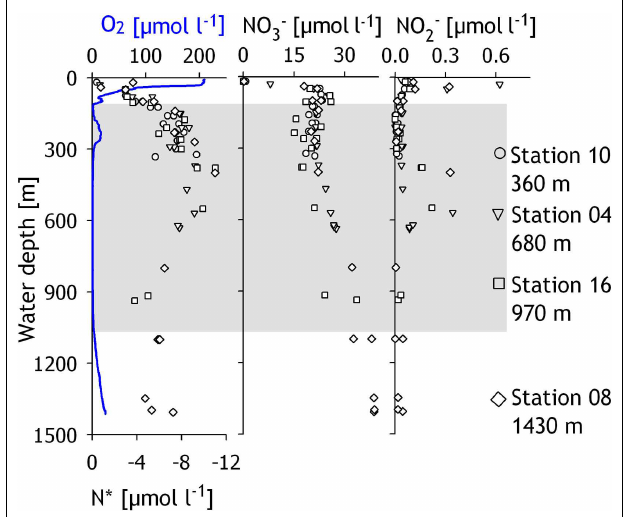
FIGURE 2 | Concentrations of dissolved oxygen, N*, nitrate and nitrite, in the water column of the Pakistan continental margin in theArabian Sea, with data compiled from all four sampling stations. N* was calculated according to Gruber and Sarmiento (1997).The shaded region depicts the extent of the oxygen minimum zone, while the different symbols denote the data points from different sampled stations. FIGURE 3 | Pore water profiles for nitrate, nitrite, iron, and sulfide for